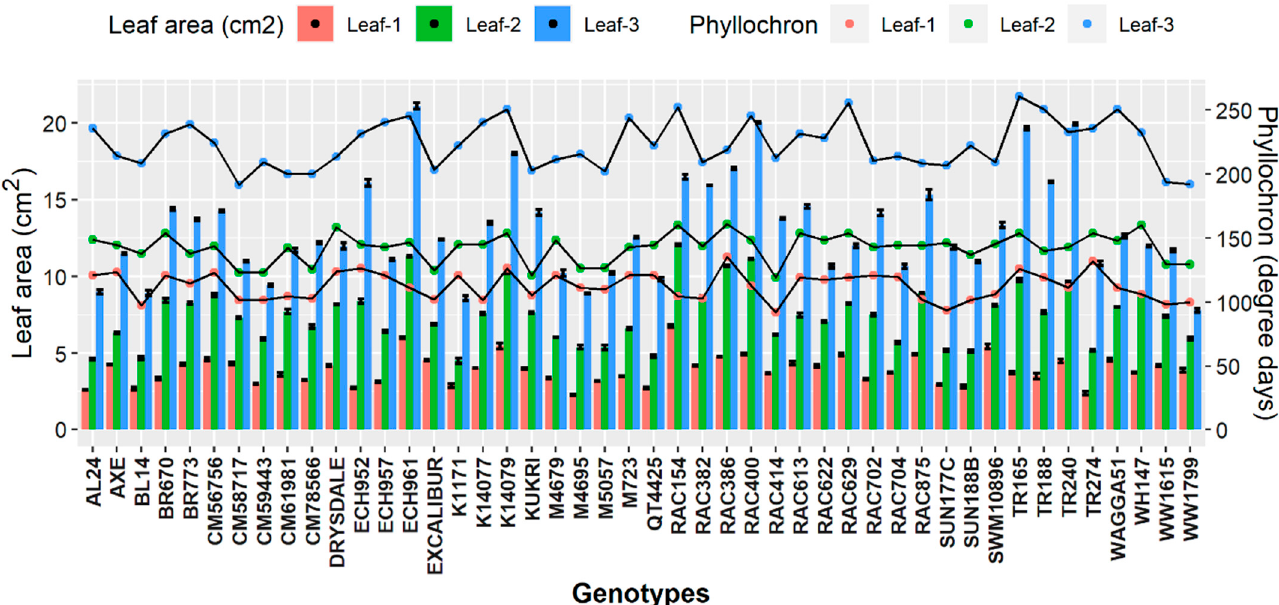
Figure 2. Early vigor components (area of leaf-1, leaf-2 and leaf-3 with respective phyllochron intervals) of 46 wheat genotypes. All values are presented with a mean of leaf area-1, 2 and 3 of three biological replicates with ± standard error (SE), SE represented with error bars.